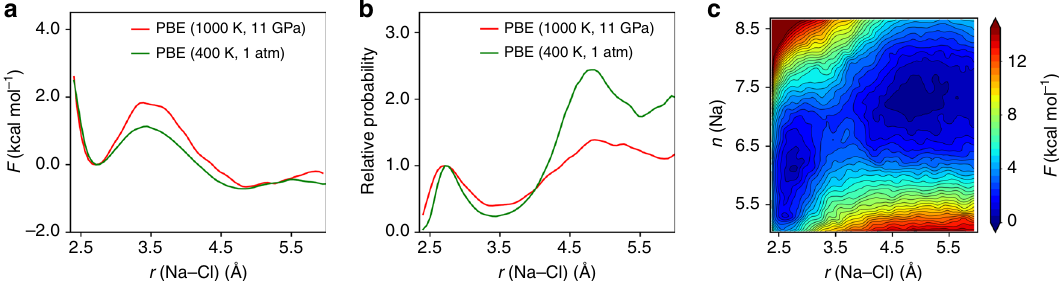
Fig. 4 Free energy surfaces (FESs) at high pressure and temperature. Results obtained with fi rst principles simulations. Calculated 1D FESs ( a ), probability distribution of ion-pair ( b ), and 2D FES ( c ). The probability distributions are aligned at the position of the contact ion pair (CIP): exp ð(cid:2)ð F ð r Þ (cid:2) F C IP Þ = k B T Þ . F is the free energy, T the temperature, r the Na – Cl distance and k B the Boltzmann coordination number ( n , Eq. (1) in the “ Methods ” ), and the corresponding minimum free energy pathway with the Nudged Elastic Band method. Our results are reported in Fig. 2c, d for the SPCE_JC potential (the results of other force fi elds are given in